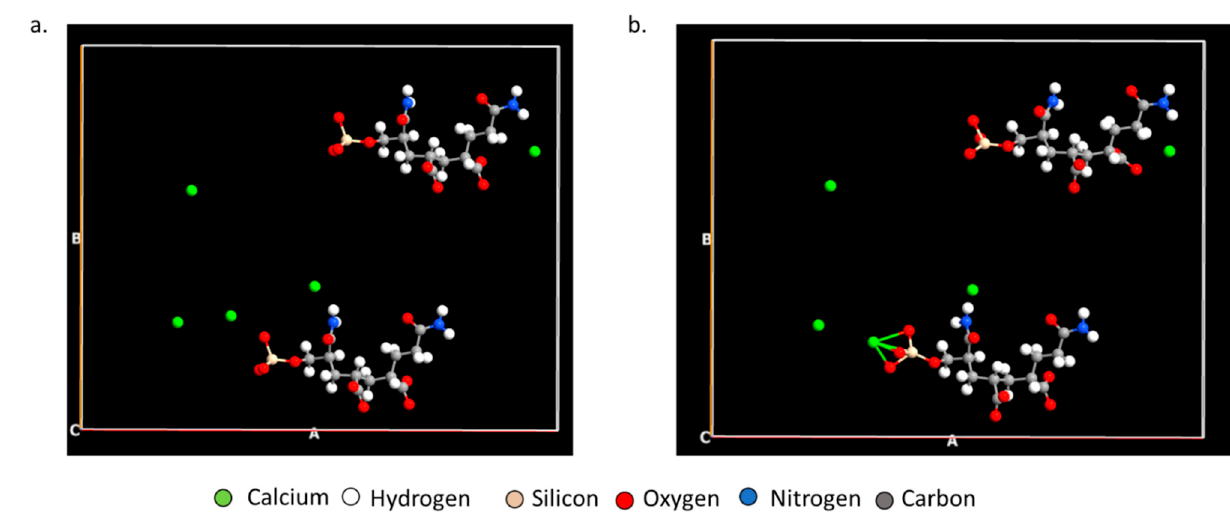
Figure 7. The ( a ) initial and ( b ) final position of the MD trajectory of PAM ‐ Silica with Ca 2+ ions.